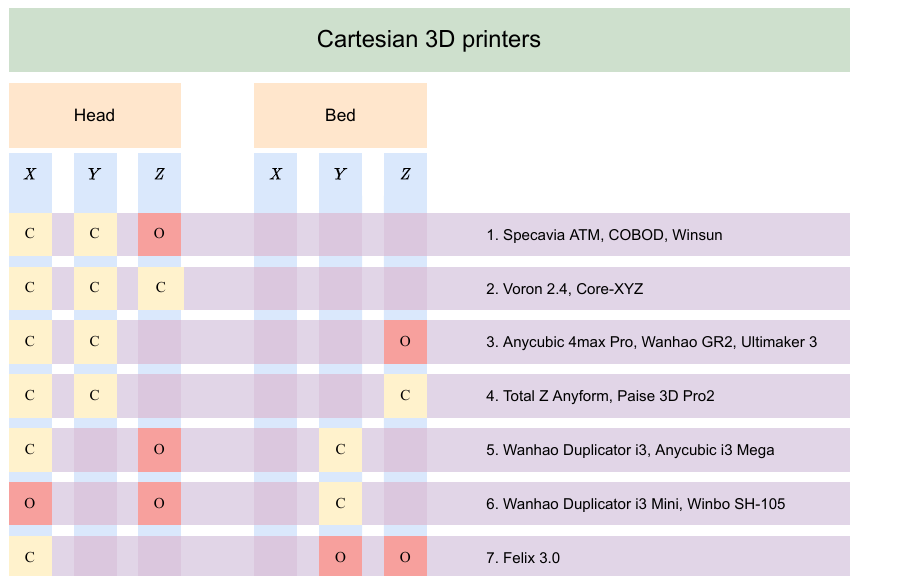
Figure A10. Fixed axes X H , Y H , Z H and actuated axes X B , Y B , Z B .